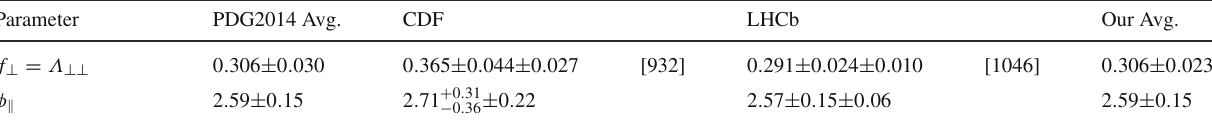
∗ 0 decays. Where values are shown in red (blue),